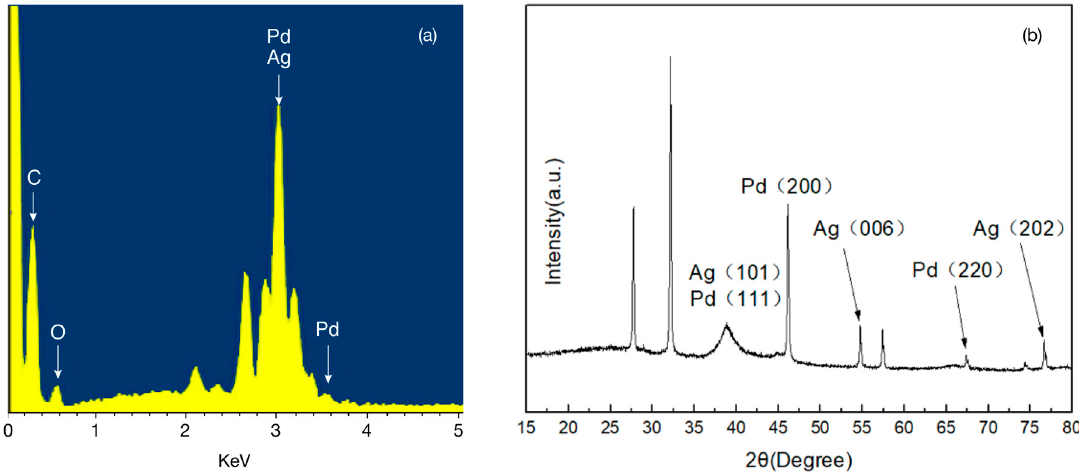
Figure 6. EDS ( a ) and XRD ( b ) analysis of a PAA film after ion exchange in 2 g/L PdCl 2 aq. for 5 h.